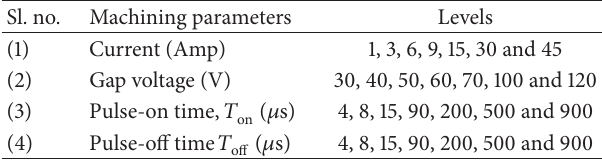
Table 2: Machining process parameters and their levels. Sl.